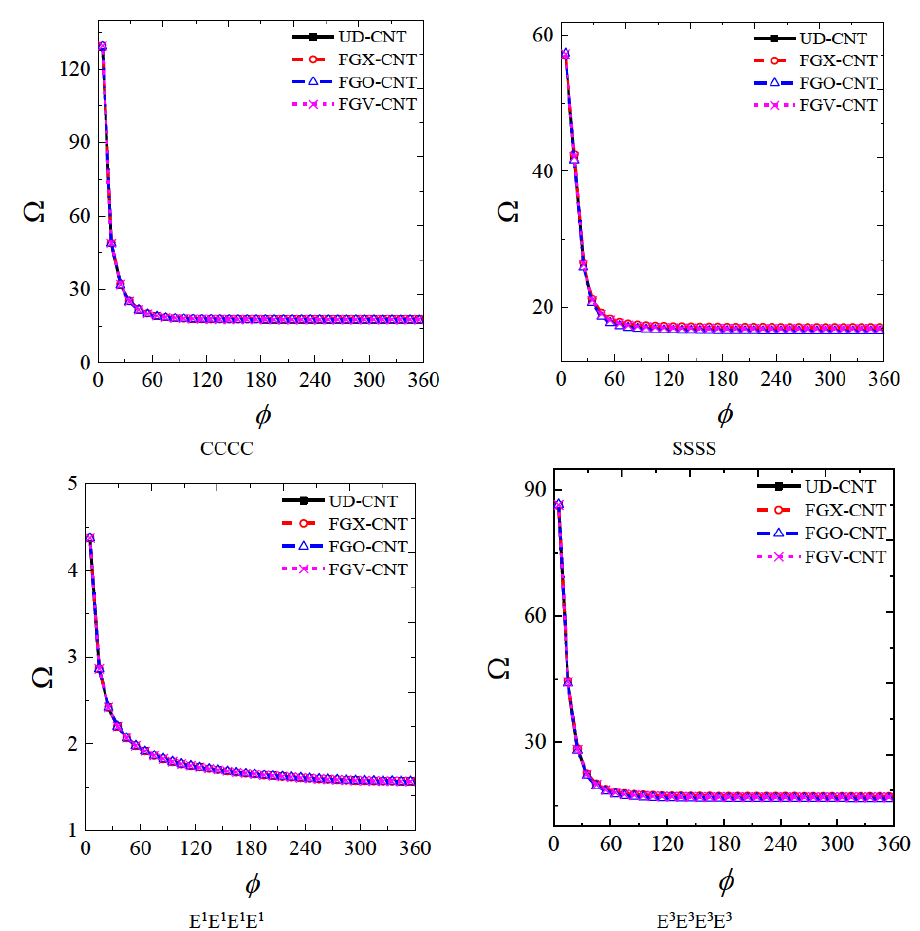
Figure 10: Variation of the fundamental frequency parameters Ω versus the sector angles ϕ for FG-CNT reinforced composite annular sector